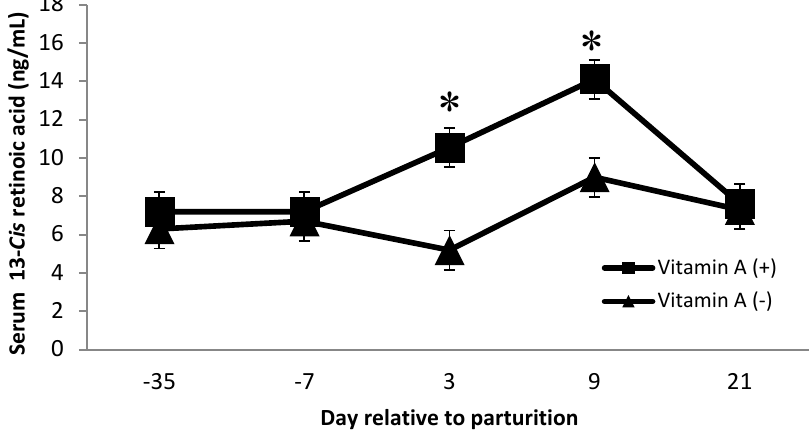
Figure 5. Serum 13- Cis retinoic acid concentrations (ng/mL) for multiparous Holstein dairy cows ( n = 80, total) that were fed diets with crude protein levels (10.3%, n = 40 vs. 12.2% dry matter basis, n = 40), and within each crude protein group fed monensin (400 mg/day per head or none) and vitamin A (110 IU/kg body weight or none) during prepartum period (from day − 35 to the day of calving). All cows received a common lactation ration postpartum. Dietary vitamin A × time interaction ( p < 0.01). Asterisks show significant differences at time point specified.